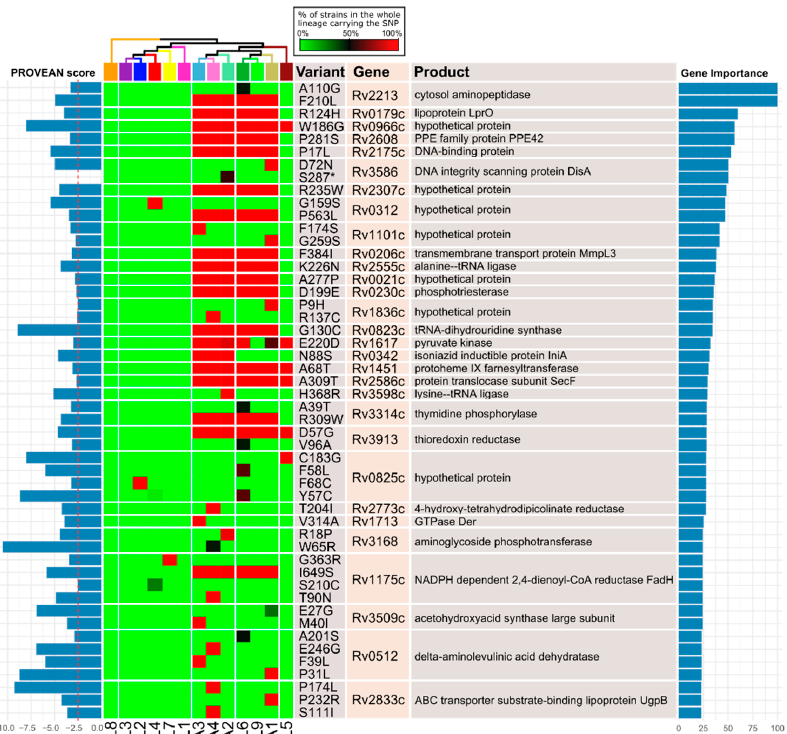
Figure 2. Supervised analysis of potentially deleterious SNPs. Potentially deleterious SNPs included amino acid substitutions predicted by PROVEAN to be deleterious (leftmost bar plot, score ≤ − 2.5, indicated in dashed red line) and premature stop codon introducing SNPs. Top 25 genes were sorted according to their importance in the classification (rightmost bar plot). The phylogenetic relationship between the lineages is shown at the